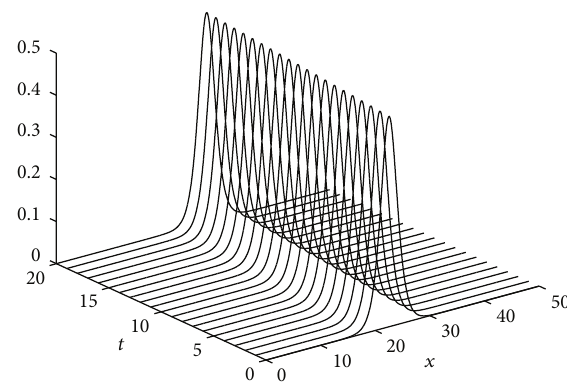
Figure 1: Single soliton 𝑈 : 𝑎 = −0.125 , 𝑏 = −3.0 , and 𝜆 = 0.5 .